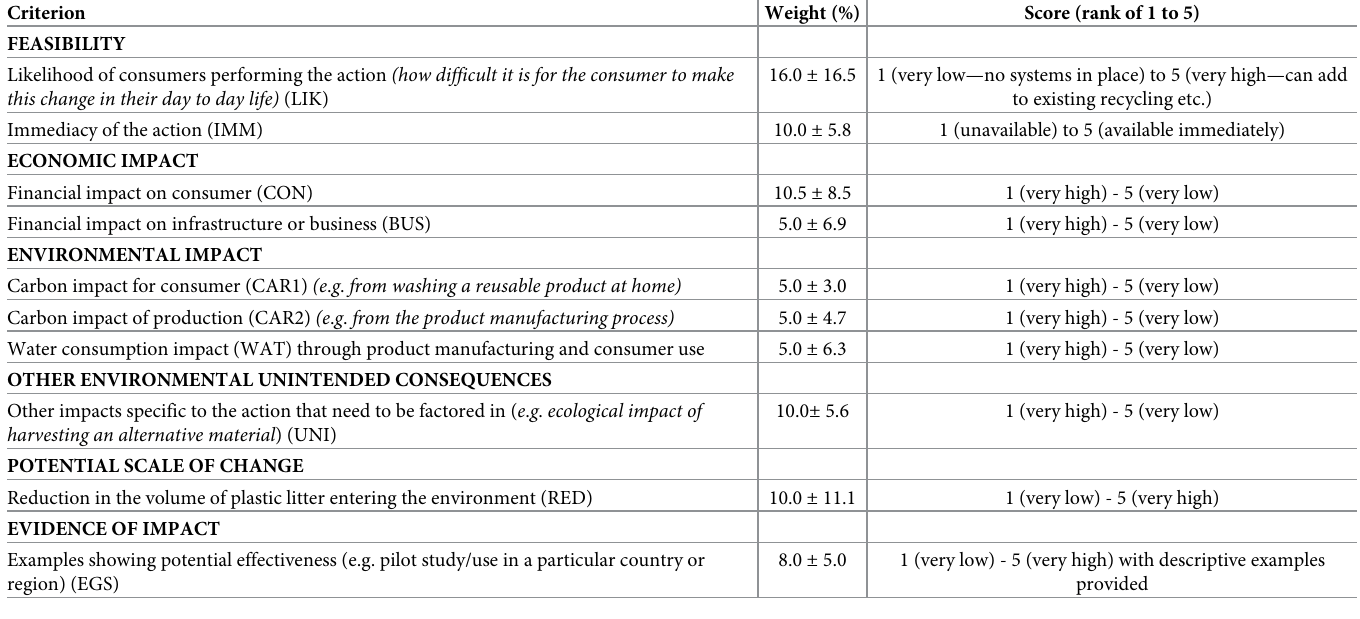
Table 1. MCDA criteria with associated scoring system and expert-determined median weightings (i.e. relative percentage importance among criteria), with their relative spread (i.e. ± interquartile